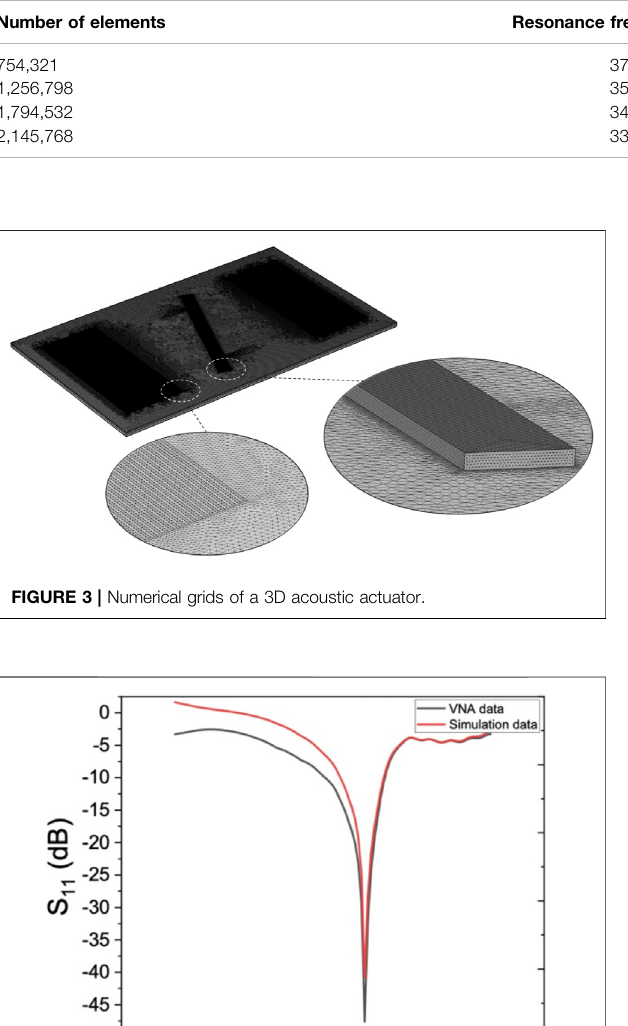
TABLE 1 | Different meshing systems for the Grid-dependency test.